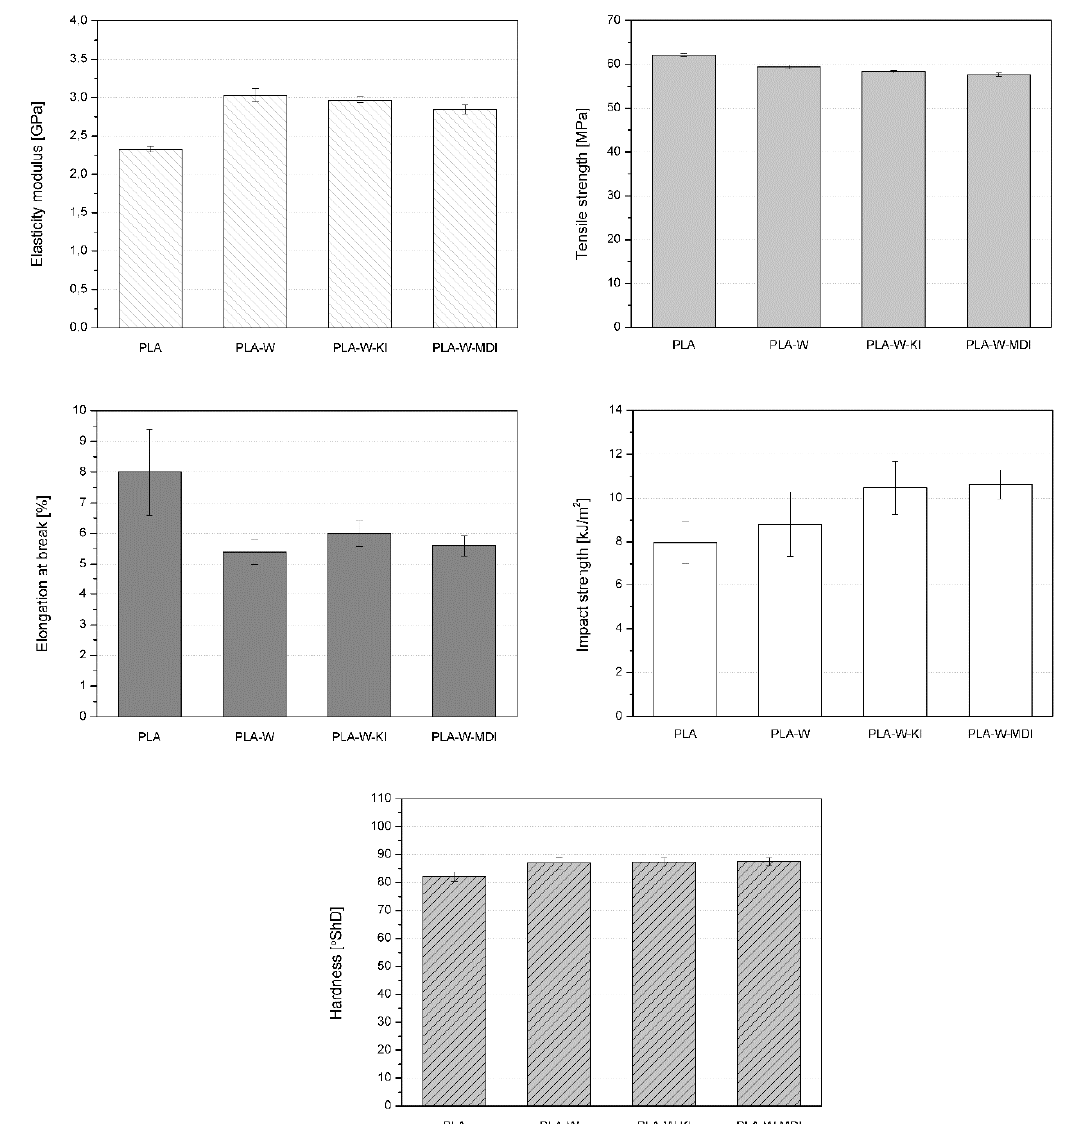
Figure 13. Mechanical properties of PLA and PLA-W composites.